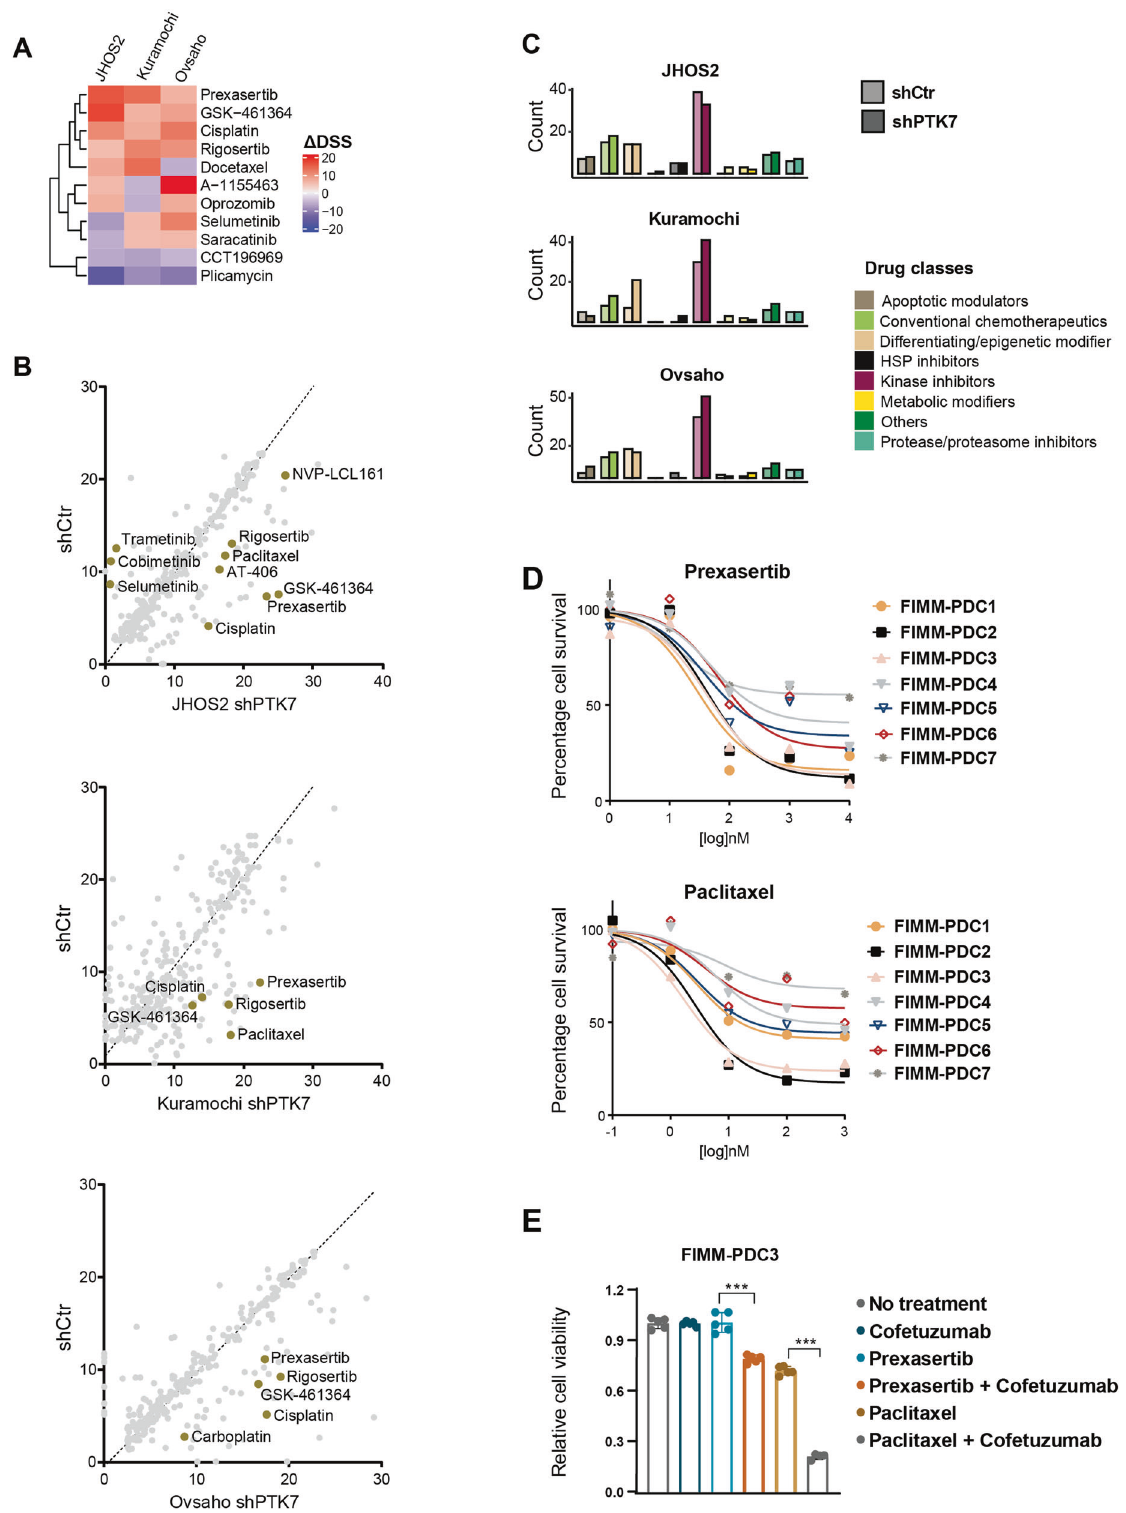
between PTK7 and ROR1/2 signaling networks, we observed